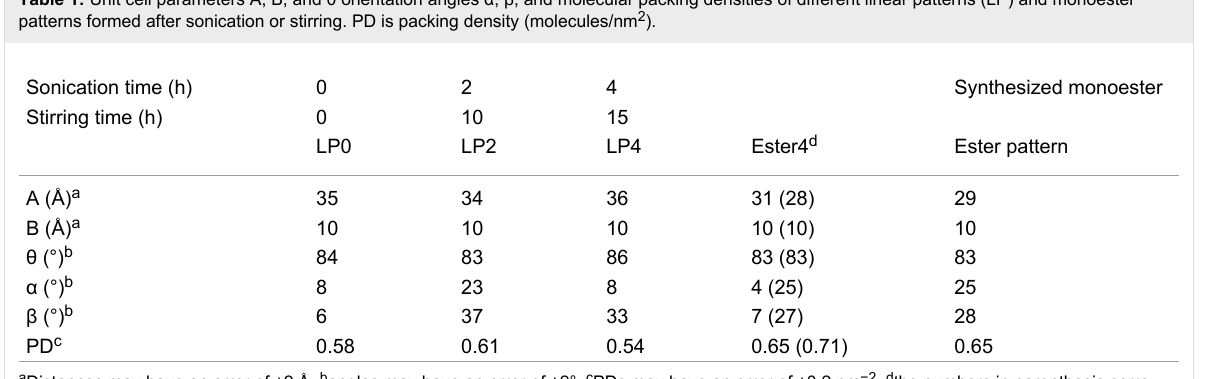
Table 1: Unit cell parameters A, B, and θ orientation angles α , β , and molecular packing densities of different linear patterns (LP) and monoester patterns formed after sonication or stirring. PD is packing density (molecules/nm 2 ).